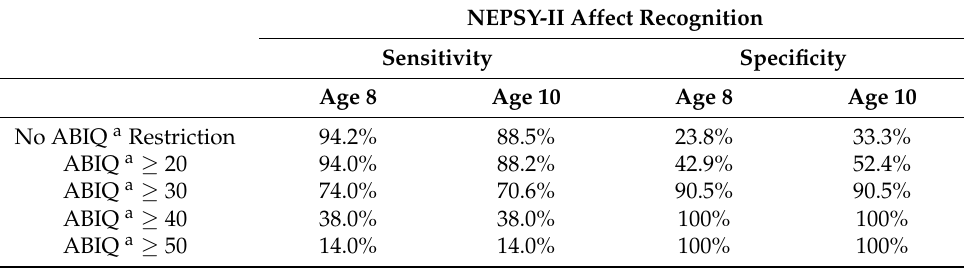
Table 4. Post hoc sensitivity and specificity for the measure below feasibility criteria.